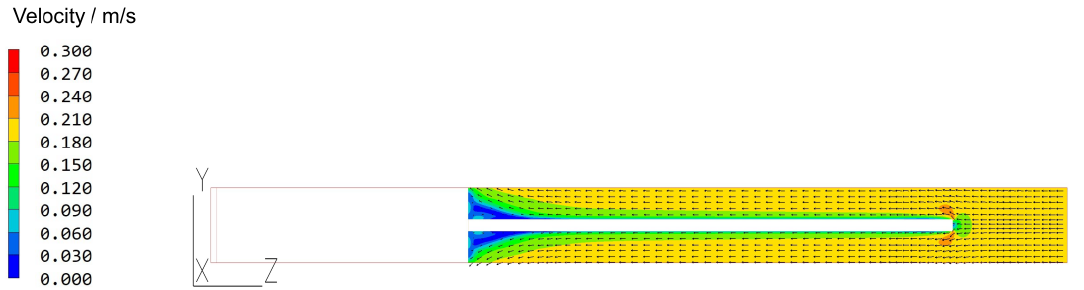
Figure 3. Simulation results showing the quasi-steady velocity distribution, which was used as initial values for the calculation to estimate thermocouple response, shown in Figure 5. The direction of gravity is from left to right. See Figure 2 for explanatory details of the simulation domain.